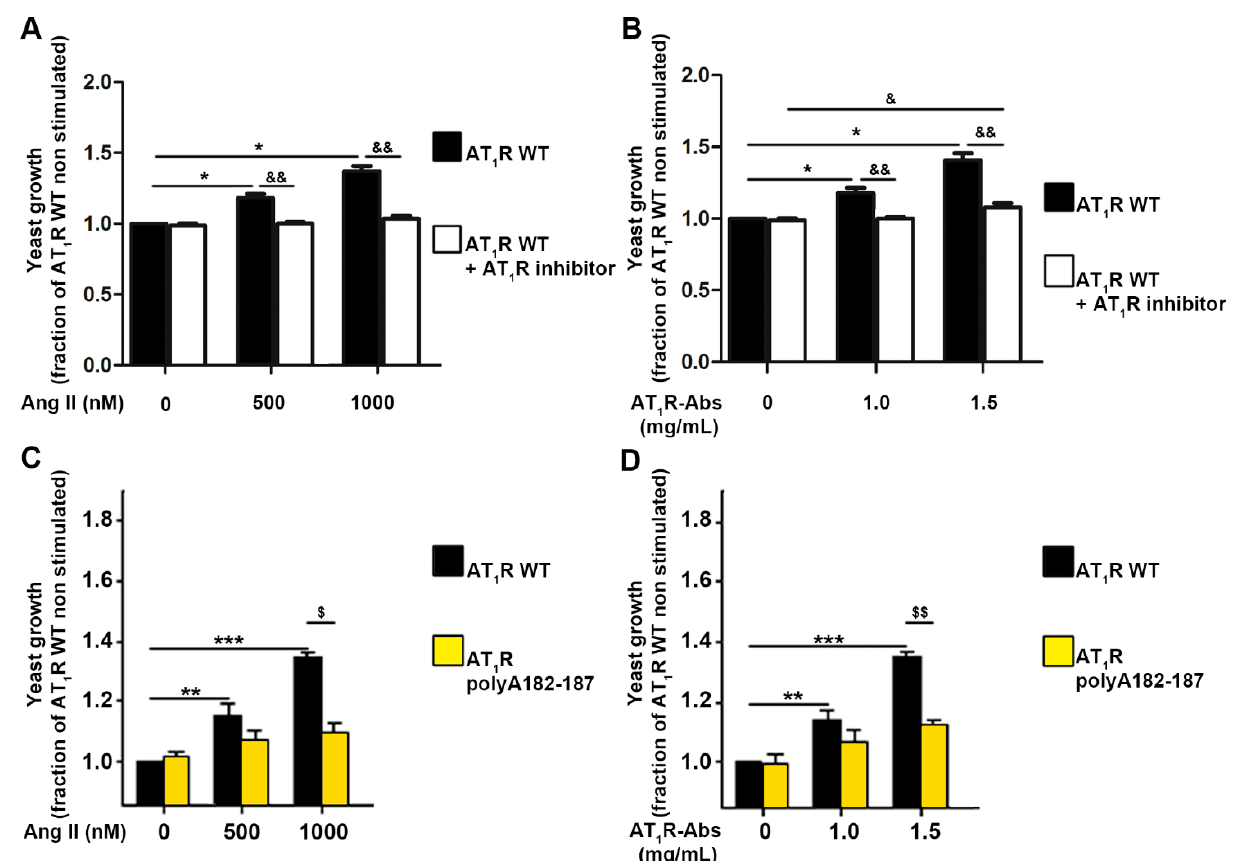
Figure 5. Contributions of extracellular loop 2 (EL2) to angiotensin II (Ang II) type 1 receptor (AT 1 R) activation. ( A ) Yeast growth is dose-dependently activated by Ang II. Yeasts transformed with a plasmid enabling the expression of the receptor were stimulated with increasing concentrations of Ang II, as indicated. Prior to stimulation, yeasts were incubated (or not) for one hour with the AT 1 R-inhibitor Valsartan at a concentration of 1 µ M. ( B ) Human AT 1 R is dose-dependently activated by AT 1 R-Abs. Yeasts transformed with AGTR1 were stimulated with increasing concentrations of antibodies. Prior to stimulation, yeasts were incubated or not for one hour with the AT 1 R-inhibitor Valsartan at a concentration of 1 µ M. ( C , D ) Yeasts were transformed with the wild type receptor (AT 1 R WT) or with the receptor variant mutated at amino acids 182-187 (AT 1 R polyA182-187). Con- structs were stimulated with increasing concentrations of Ang II ( C ) or AT 1 R-Abs ( D ). SEMs derived from four to six experiments are shown along with p -values for Wilcoxon or Mann–Whitney tests. ( A , B ) * p < 0.05 as compared with AT 1 R WT without stimulation and without inhibitors; & p < 0.05, && p < 0.01 as compared with AT 1 R WT pre-incubated with AT 1 R inhibitors (Val- sartan). ( C , D ) ** p < 0.01, *** p < 0.001 as compared with AT 1 R WT without stimulation; $ p <